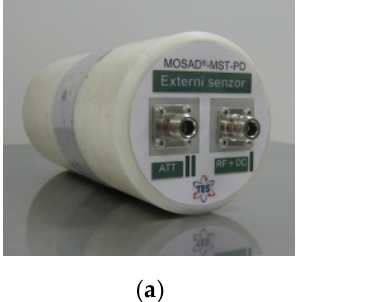
Figure 16. The waveform of the PD simulating impulse signal ( a ); the magnitude spectrum of the simulating signal ( b ).